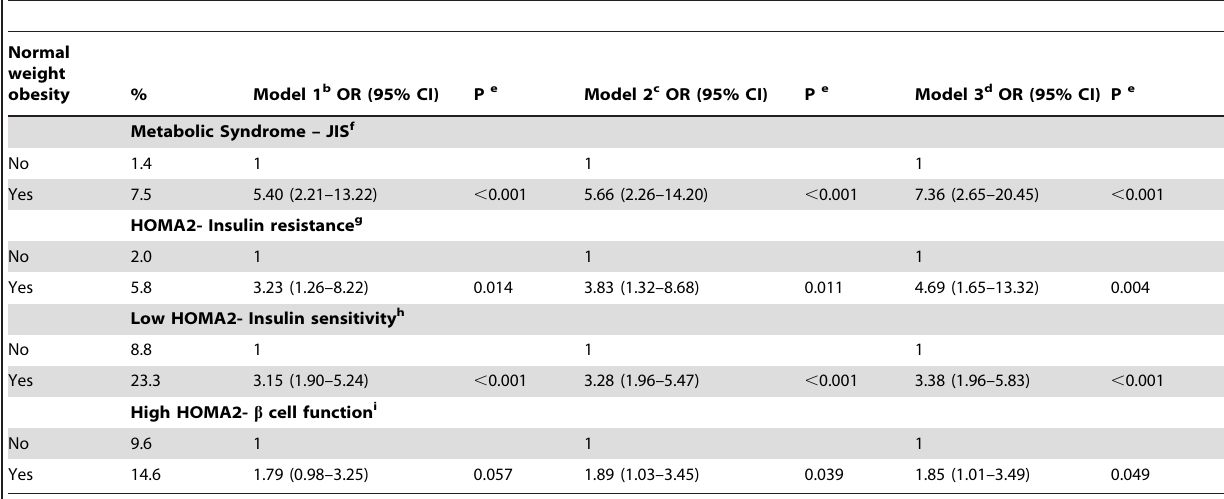
Table 6. Associations between normal weight obesity defined as high percent body fat a with metabolic syndrome and insulin resistance, insulin sensitivity and b cell function, 1978/79 Ribeira˜o Preto birth